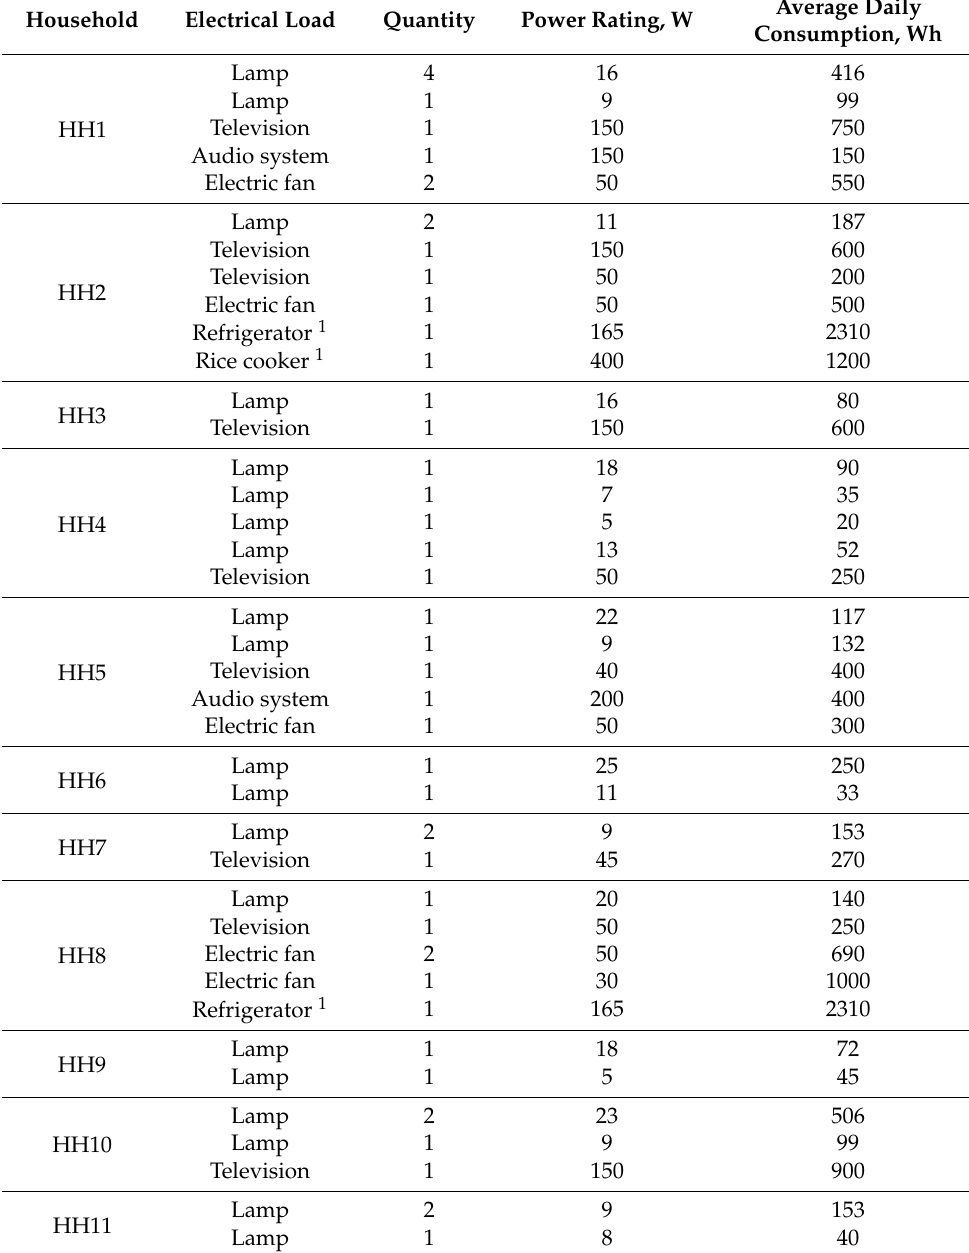
Table 8. Electrical loads in the 11 households of the Gilutongan Island solar